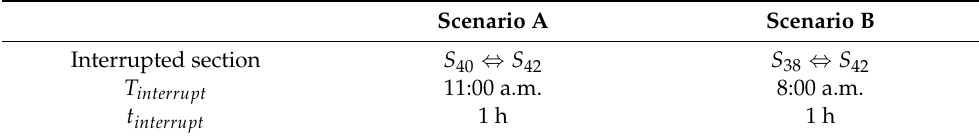
Figure 8. Map of the partial URT network in Ningbo. Table 6. Basic information of the two scenarios.